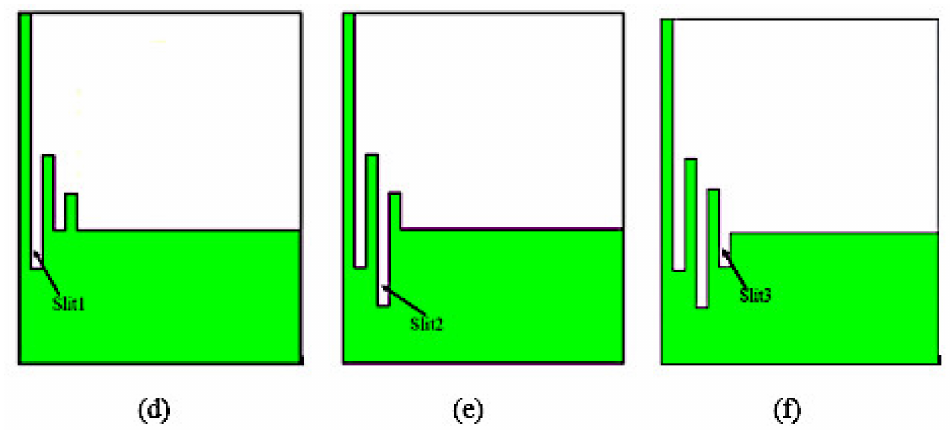
Figure 5. Development steps of the ground plan: ( a ) step 1; ( b ) step 2; ( c ) step 3; ( d ) step 4; ( e ) step 5; ( f ) step 6.